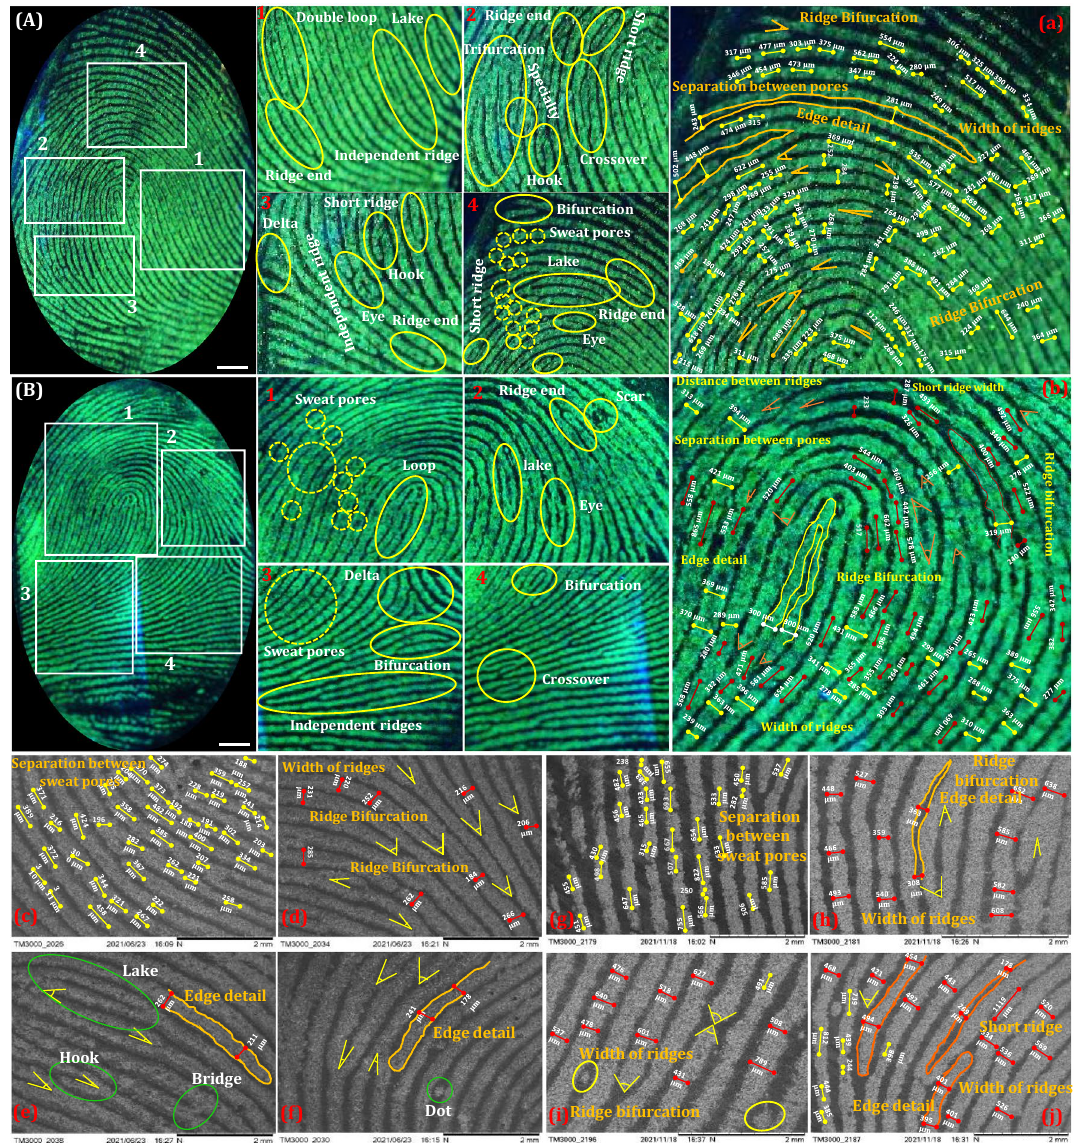
Figure 5. ( A and B ) Photographed RGB images of the FPs of two different donors developed using LZOT:NH 4 Cl (4 wt. %) NPs under UV 254 nm light; (1–4) Enlarged portions of the FPs of ( A ) and ( B ), revealing detailed ridge details, including level I-III characteristics; ( a and b ) Magnified RGB images portion of the FPs, which showing most authenticated level-III ridge features; ( c – j ) SEM images of the developed FPs, revealing positions of the sweat pores, distance between successive pores, bifurcation and hook angle, shape of the ridge end, width of the ridges, ridge end angle details (Scale bar: 5